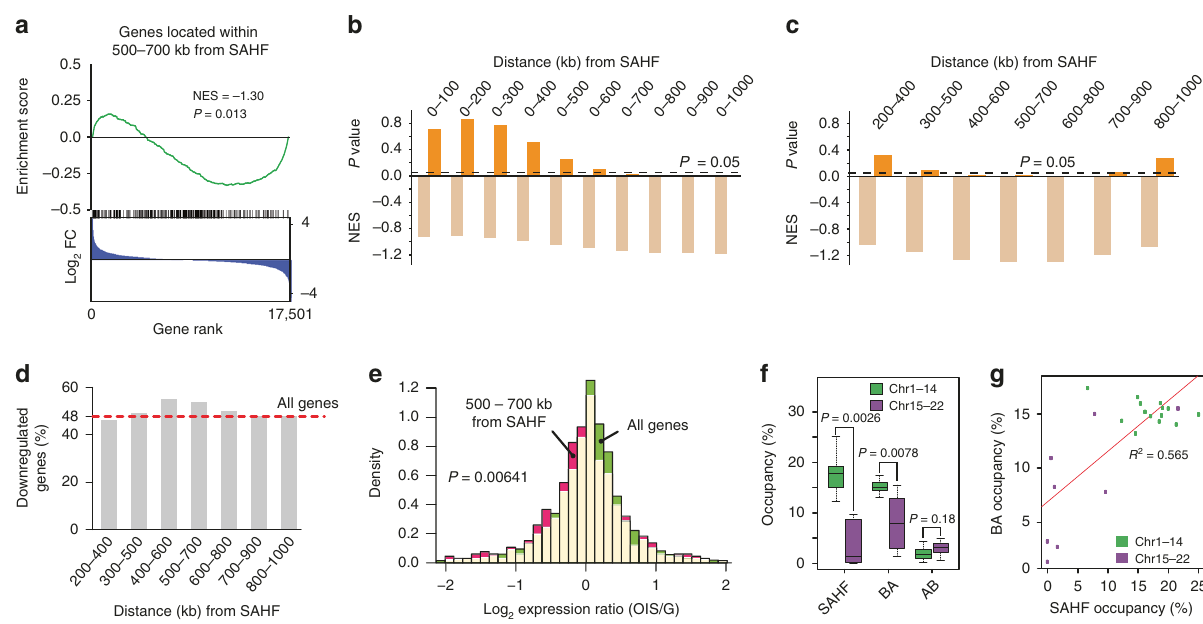
Fig. 3 Transcriptional downregulation near SAHF-forming regions. a GSEA of the 495 genes located within the 500 – 700 kb range from SAHF, from all chromosomes (Methods). All human genes were ranked by expression fold changes (FC), calculated as levels of gene expression in OIS cells divided by levels of expression in growing cells (blue distribution). The distribution of the target genes ( n = 495) is shown by the row of black tick marks (also green line). The target genes were frequently downregulated in OIS cells compared to growing cells, indicated by the negative normalized enrichment score (NES). The signi fi cance of the biased distribution was assessed by an empirical phenotype-based permutation test 46 . b Statistical signi fi cance and NES of changes in gene expression, between OIS and growing cells, for groups of genes positioned within the indicated distances from SAHF, as analyzed using GSEA. c Same data as panel b , but GSEA was performed on groups of genes positioned within the indicated 200 kb windows from SAHF. d Percent of downregulated genes positioned within the indicated 200 kb windows. Note that 48% of all human genes were downregulated upon OIS, serving as a control distribution for downregulated genes. e Expression ratios between OIS and growing cells were calculated for the genes located within the 500 – 700 kb range from SAHF, and the distribution was plotted against the ratio. All human genes were also subjected to the same analysis (control). P -value was calculated by a two-sided Mann – Whitney U test. f Percent of chromosome occupied by SAHF in chromosomes 1 – 14 and 15 – 22 shown as boxplots (central bar represents the median with boxes indicating the upper and lower quartiles, and whiskers extend to the data points, which are no more than 1.5× the interquartile range from the box). P -value was calculated by a two-sided Mann – Whitney U test. BA- and AB-switching regions were analyzed identically. g Correlation between percent of chromosome occupied by SAHF and by BA-switching regions, in the indicated chromosome groups. The coef fi cient of determination ( R 2 ) for a linear model fi t (red line) was